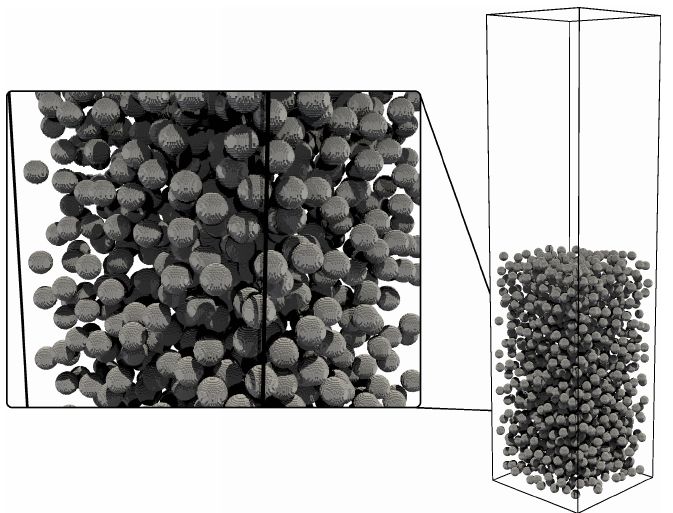
Figure 10. Random distribution of spheres in the computational domain for the hindered settling simulations with a solid volume fraction of